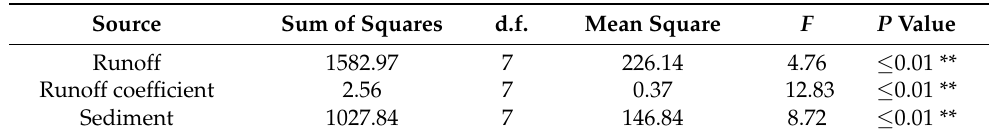
Table 4. ANOVA for the effect of slope gradient on runoff, runoff coefficient, and sediment yield. ** P < 0.01.